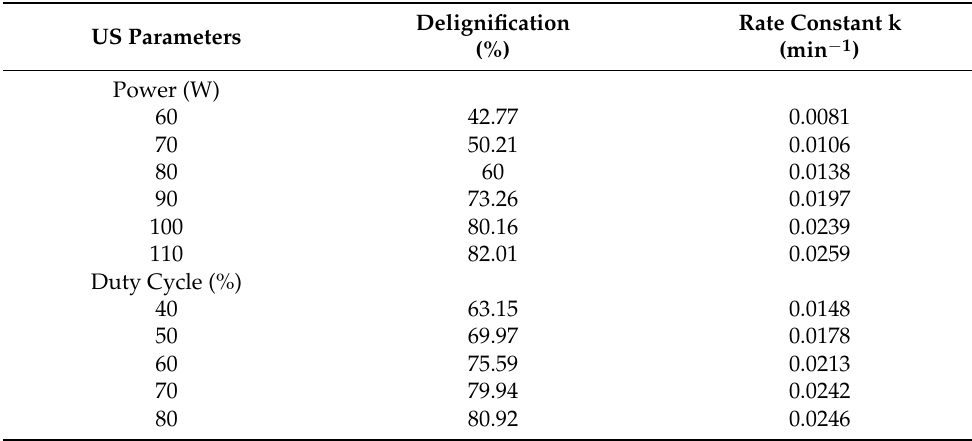
Table 2. Effect of US parameters on lignin removal rate.